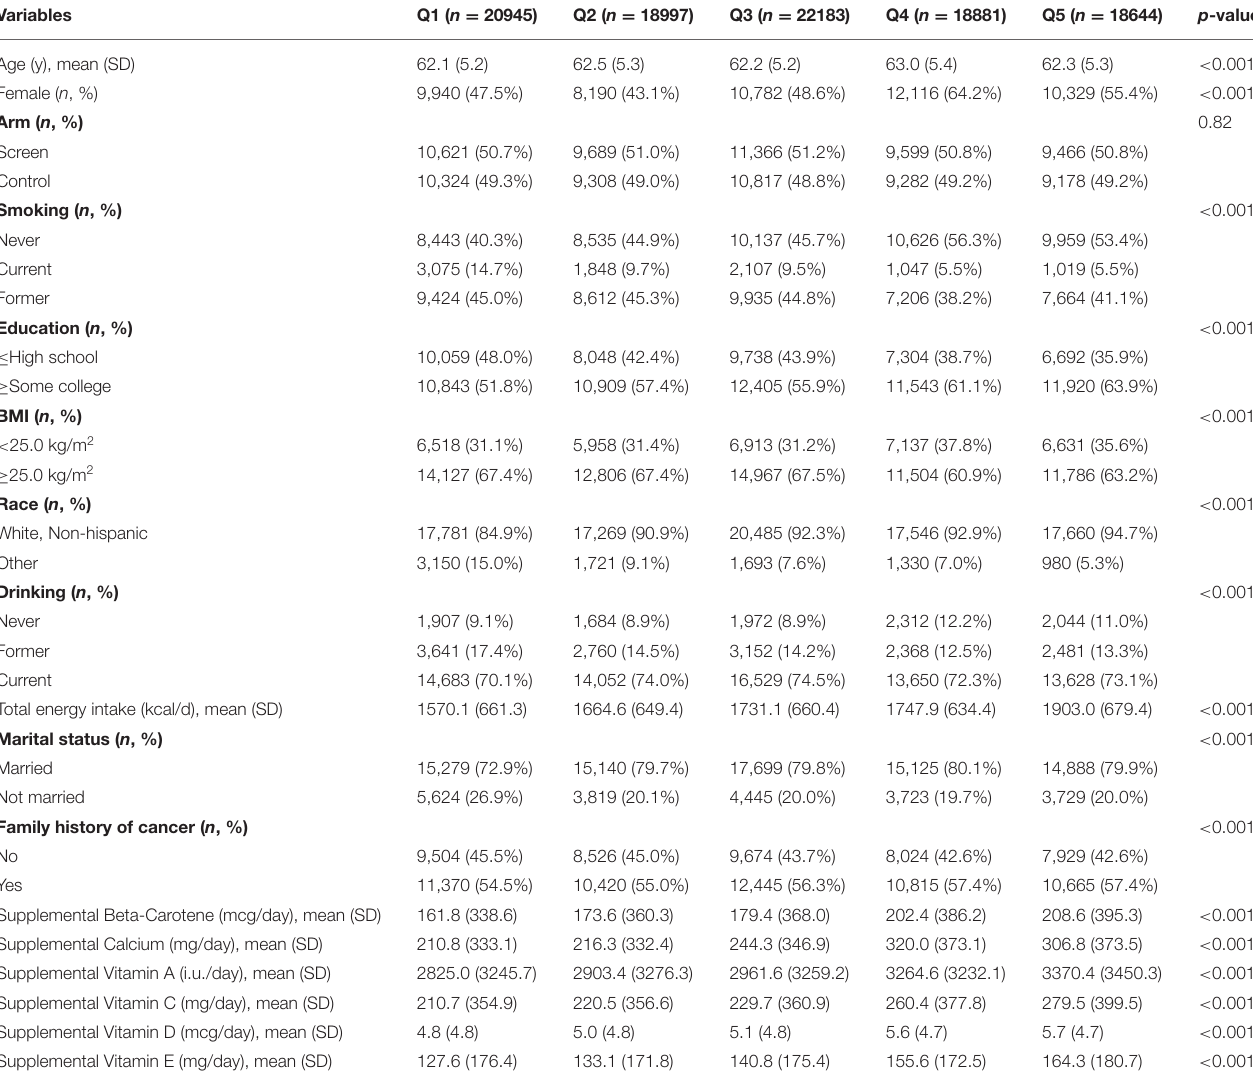
TABLE 1 | Main characteristic of participants in the PLCO cancer screening trial by carrot intake.